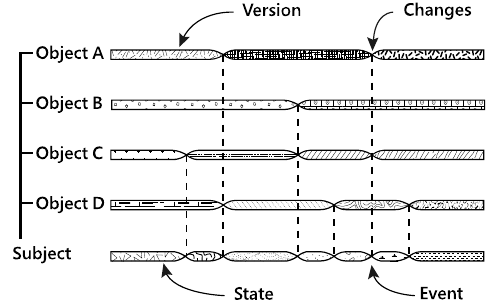
Figure 3. The state of object and the relationship between object and subject (from Langran, G., Chrisman, N., R., 1988, redraw